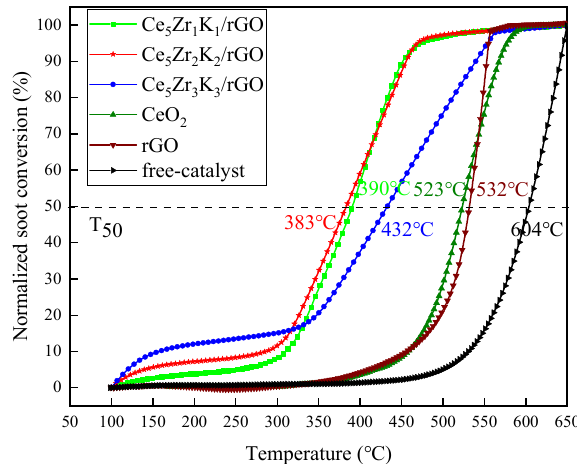
Figure 11. Normalized soot conversion versus temperature of CeZrK/rGO catalysts and free-catalyst under loose contact mode in simulated air (21% O 2 + 79% N 2 ).